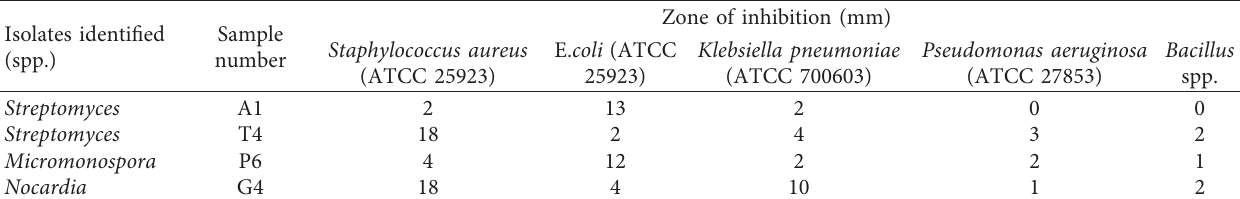
Table 4: Secondary screening of the different isolates with effective results. Isolates identified